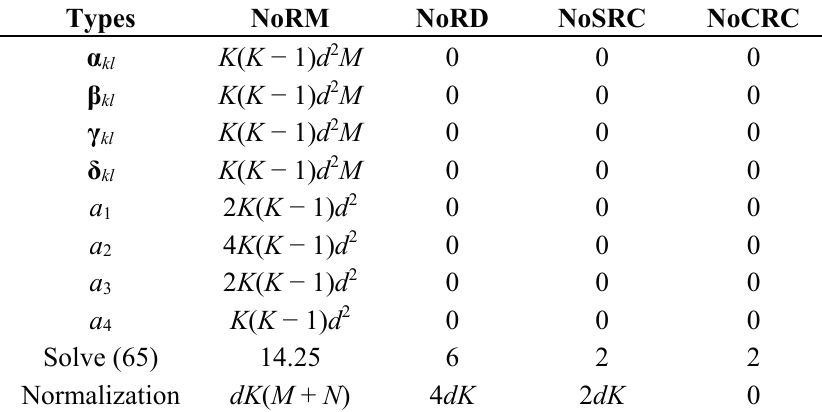
Table 2. Complexity of one line search.